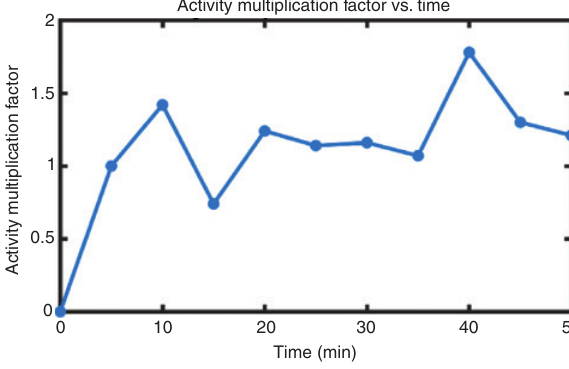
Figure 10: Activity multiplication